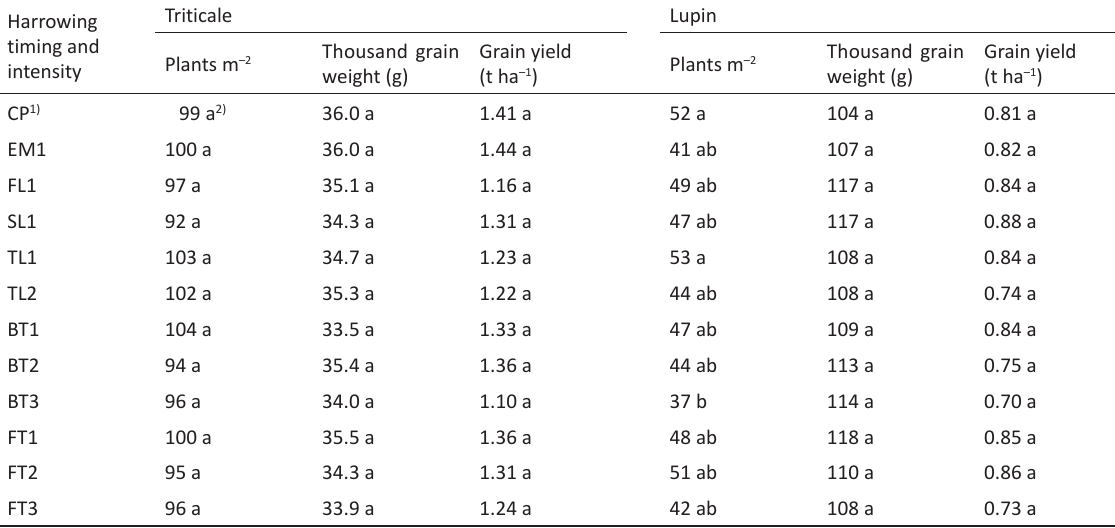
Table 6. The effect of weed harrowing on the plant density, thousand grain weight and grain yield of triticale and lupin. Means averaged over 2015–2017. Harrowing timing